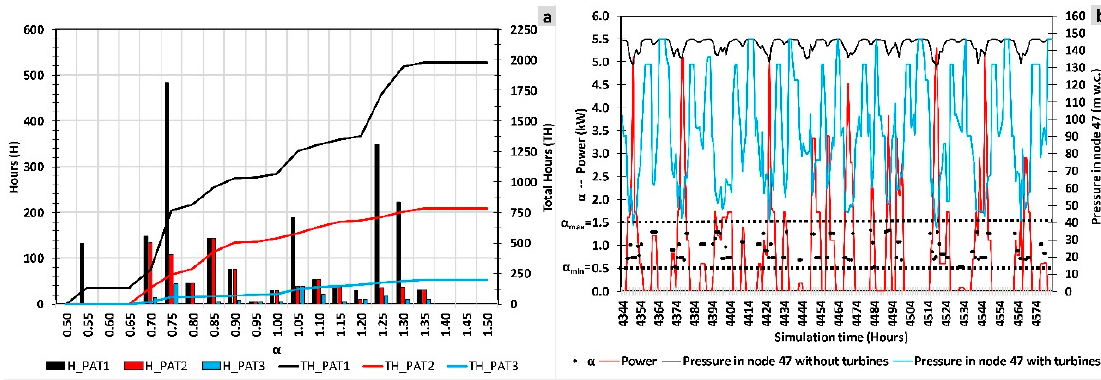
Figure 10. Operation time, rotational speed, generated power and pressure in line 47.